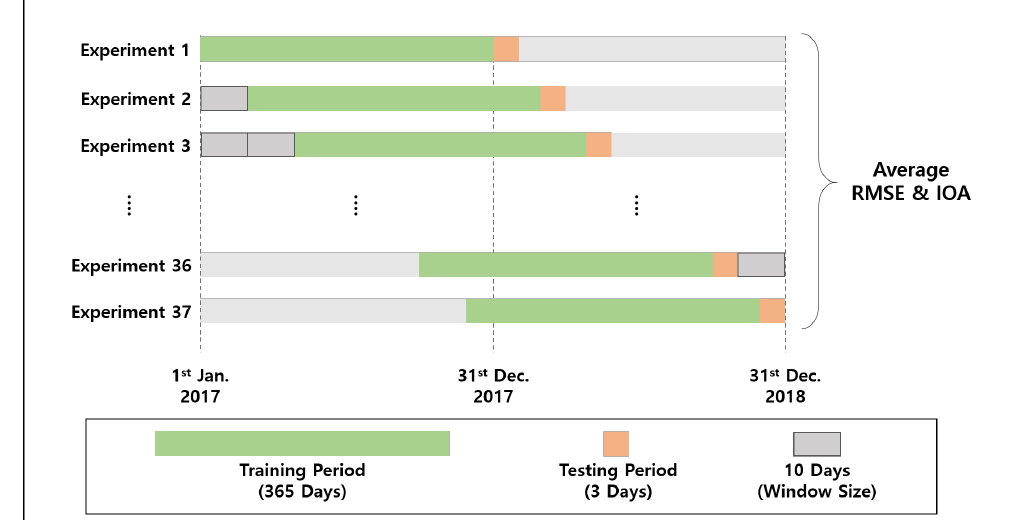
Figure 4. The experimental settings based on the sliding window approach where the window size is 10 days with 365 days of thetraining period and three days of the testing